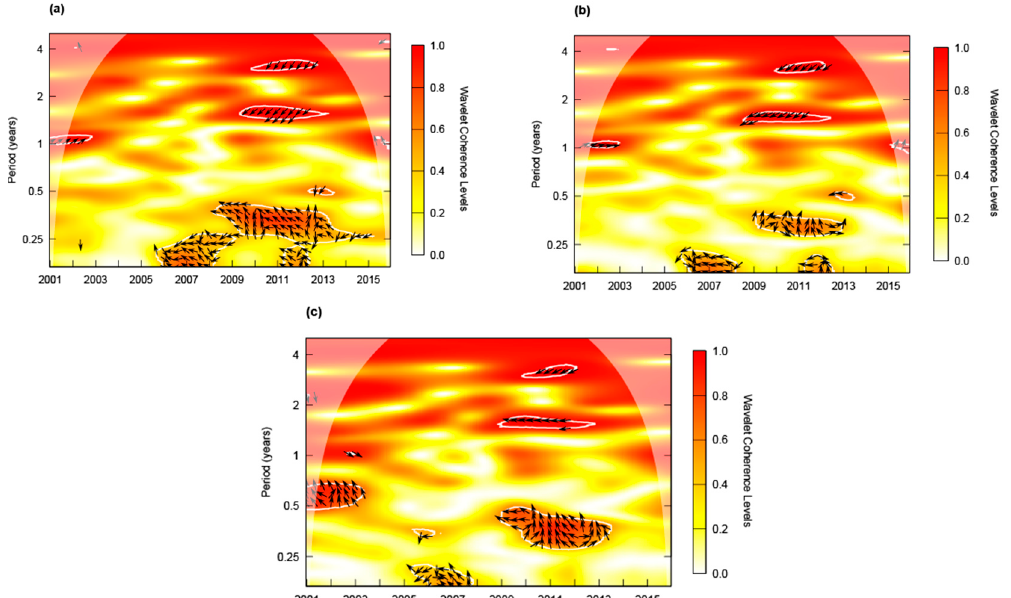
Figure 4. Wavelet coherence between SPEI–NDVI in 2001–2015. ( a ) SPEI1–NDVI, ( b ) SPEI3–NDVI, ( c ) SPEI6–NDVI.